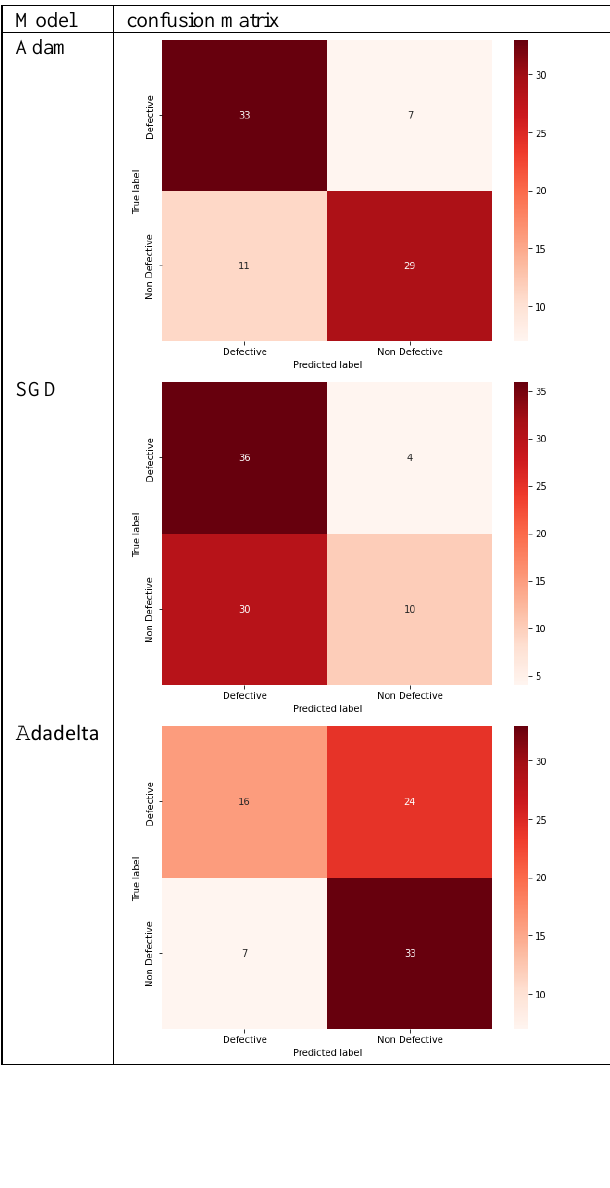
Fig. 7. Validation Accuracy by epochs